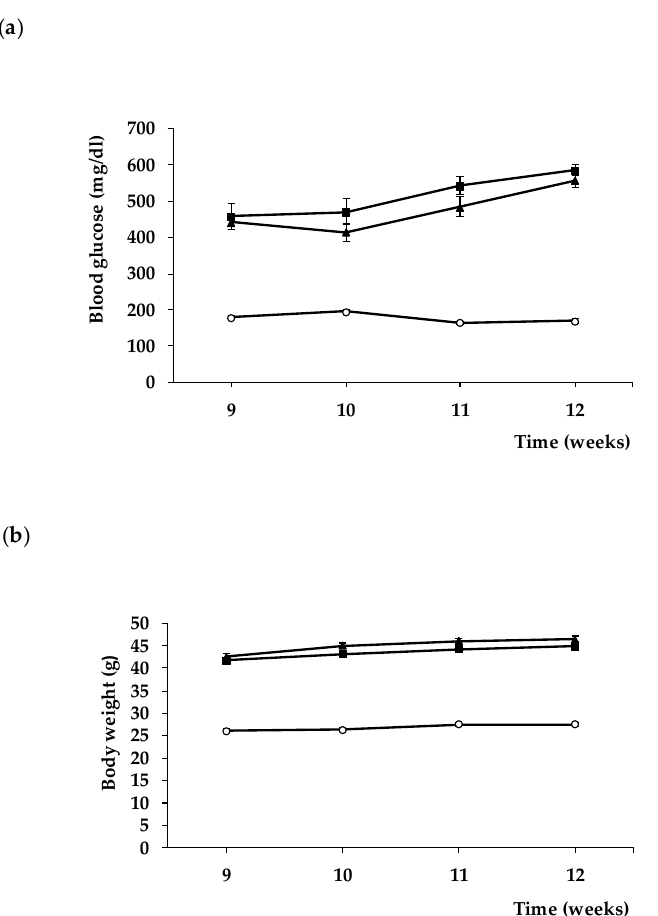
Figure 8. Evolution of blood glucose ( a ) and body weight ( b ) in db/+ mice (white circles), db/db mice treated with vehicle (black squares), and db/db mice treated with sitagliptin eye drops (black trian- gles).